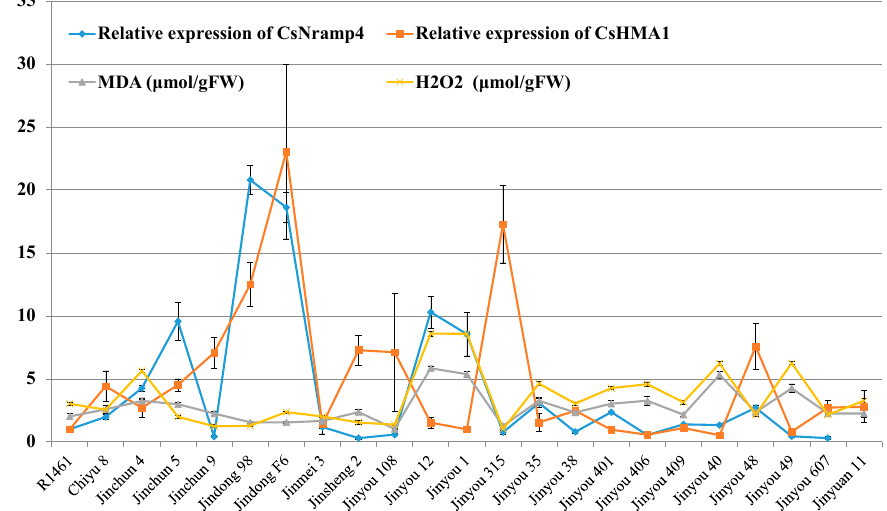
Figure 5. Association analysis of cucumber Cd-related transporter gene expression profiles and Cd-induced REDOX reaction. Correlation analysis of the expression of CsNramp4 and CsHMA1 in 23 cultivated varieties along with MDA and H 2 O 2 content in cucumber seedlings. Ten-day-old cucumber plants were grown in Yamazaki nutrient solution supplemented with 0 and 0.5 µ M Cd for 48 h and 4 days.